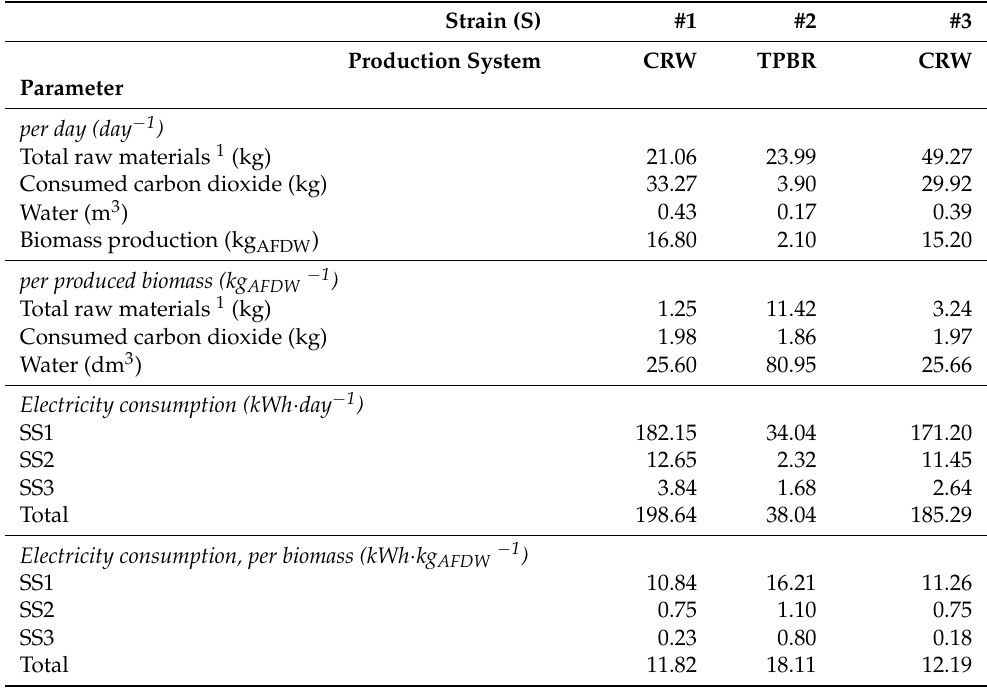
Table 3. Mass and energy balances for each strain production, obtained from the SuperPro Designer model, at the actual production